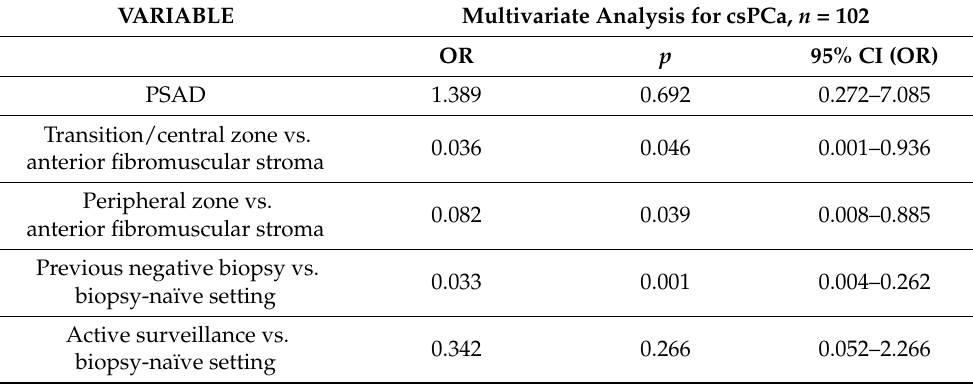
Table 3. Multivariate analysis showing the variables associated with a csPCa on the target biopsy in only the PI-RADS score 3 cohort.